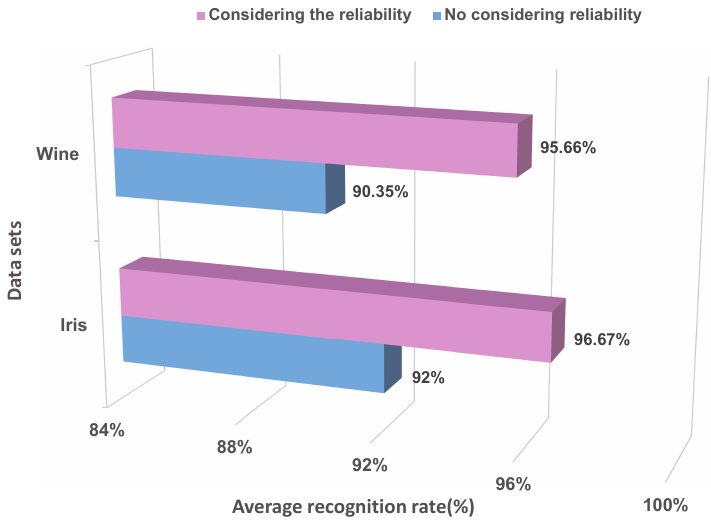
Figure 6. The comparison of considering the reliability or